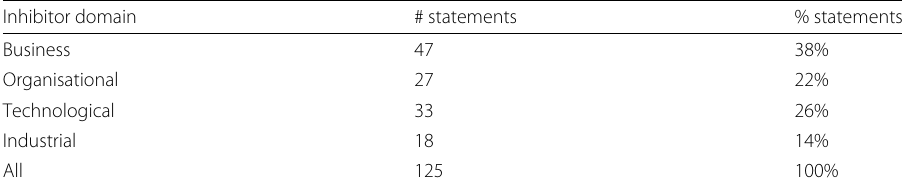
Table 13 Assignment of statements from open-ended question on inhibitors to four inhibitor domains Inhibitor domain